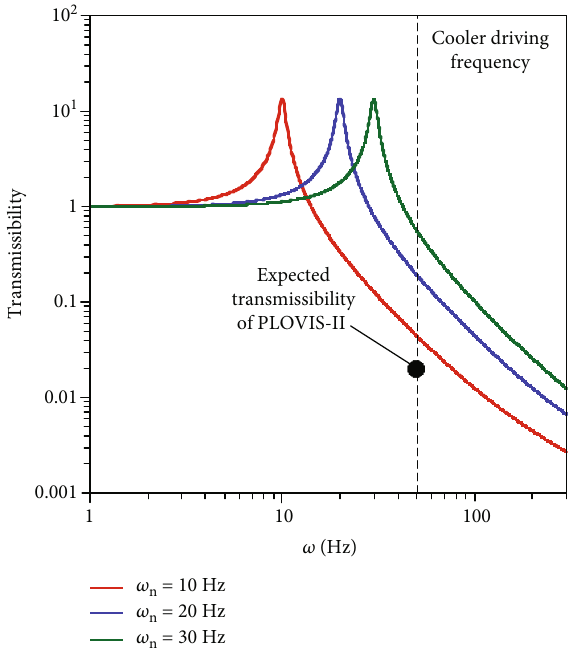
Figure 5: Transmissibility with respect to isolation system with various ω n